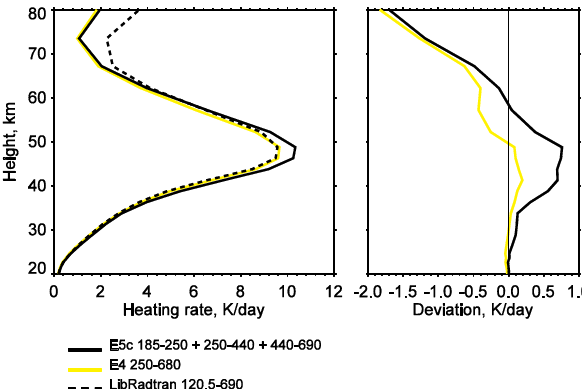
Figure 3. Daily averaged shortwave heating rates in Kday − 1 for tropical standard atmosphere and solar minimum irradiance cal- culated by E4 (250–680nm), E5c (185–690nm) and libRadtran (120.5–690) (left) and deviations of E4 and E5c to libRadtran